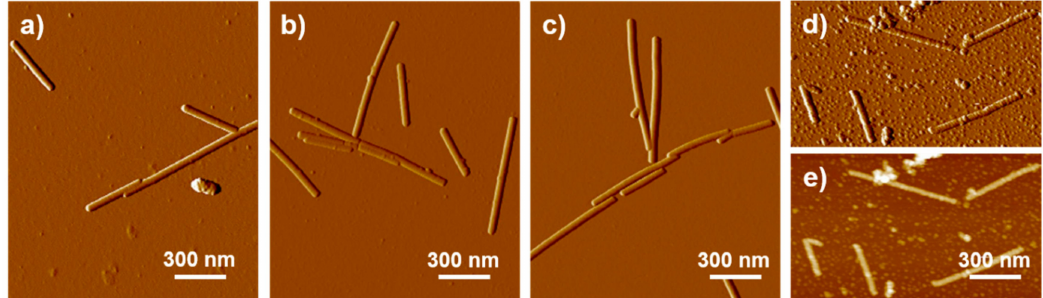
Figure 2. AFM amplitude images of TMV-Cys virus particles treated: ( a ) 1 h in tetrahydrofuran (THF), ( b ) 1 h in THF / TEA, ( c ) 2 h with PFS in THF / TEA at room temperature. ( d ) AFM amplitude image of viruses from ( c ) mineralized 5 min with ZnS and ( e ) AFM height image of ( d